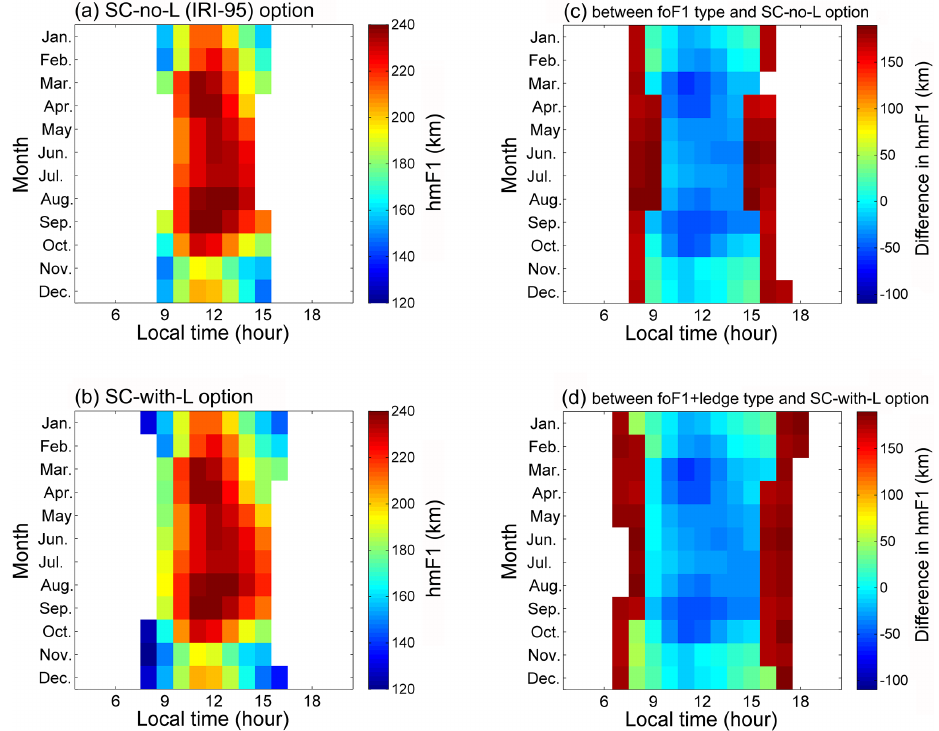
Figure 5. The monthly median hm F1 values for (a) SC-no-L and (b) SC-with-L options, modeled by of IRI-2012 with the B0 choice of Bil-2000, during January–December 1996. The differences in hm F1 (c) between fo F1 type and SC-no-L option, and (d) between fo F1 + ledge type and SC-with-L option are